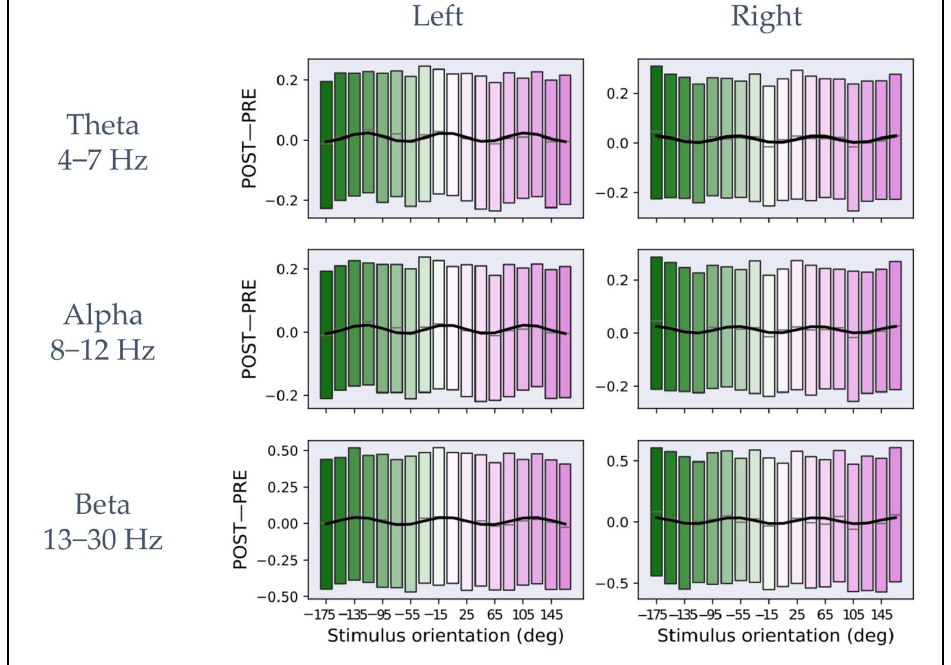
Figure 3. Plots of iPLV differences between post- and pre-stimulus intervals averaged across macro- orientations of 20° for theta, alpha, and beta frequency bands. In the ( left column ), the plots represent the average as a function of the macro-orientation for the channels close to the left primary motor cortex for each frequency band. In the ( right column ), the plots represent the mean as a function of orientation for the channels close to the right primary motor cortex for each frequency band. In each plot, the rectangular boxes represent the data from the 25th to the 75th percentile with the same reference colors as Figure 1B. The lines inside the rectangular boxes represent the mean (gray